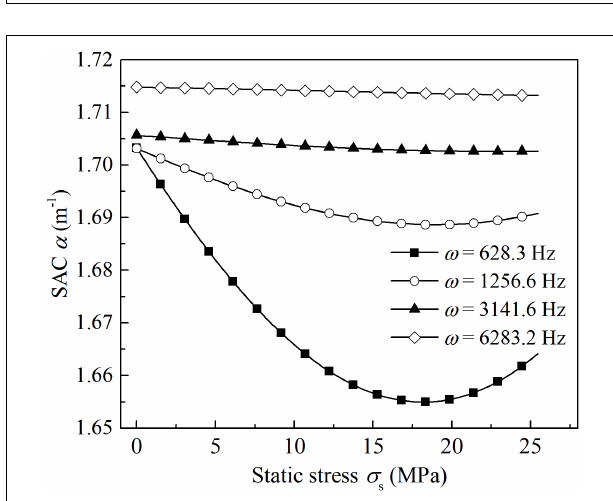
FIGURE 7 | The variation in spatial attenuation coefficient versus static stress under different frequencies ( x = 0.5 m).